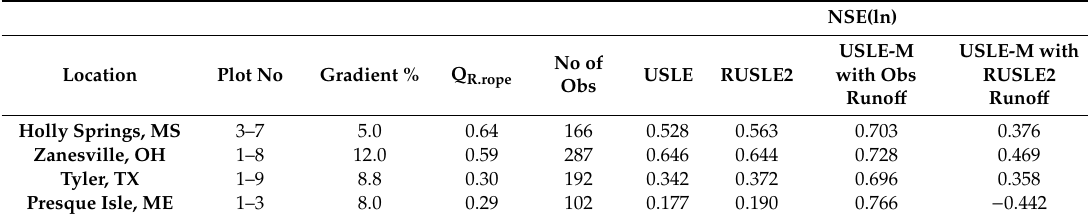
Table 1. Nash–Sutcli ff e e ffi ciency index (NSE(ln)) values obtained soil loss predictions on the four bare fallow plots in the USLE database using the USLE, RUSLE2, and the USLE-M. All the plots were 22.1 m long (source: Kinnell [53]). OH: Ohio, TX: